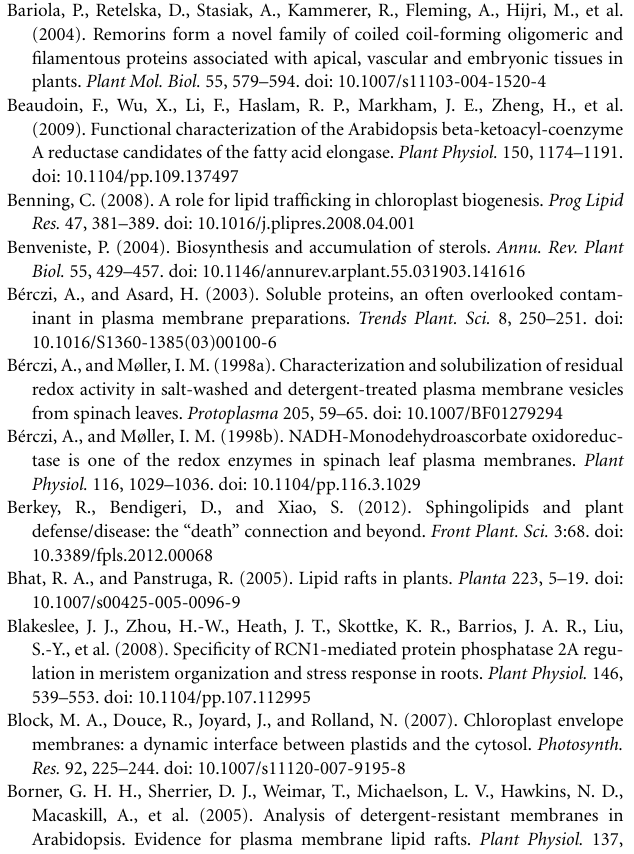
Supplemental Figure 5 | Barplots of calculated protein abundances from all analyzed proteins across all experiments. Supplemental Figure 6 | Barplots of amounts from mucilage side chain residues using HPLC system for detection after hydrolysis of purified